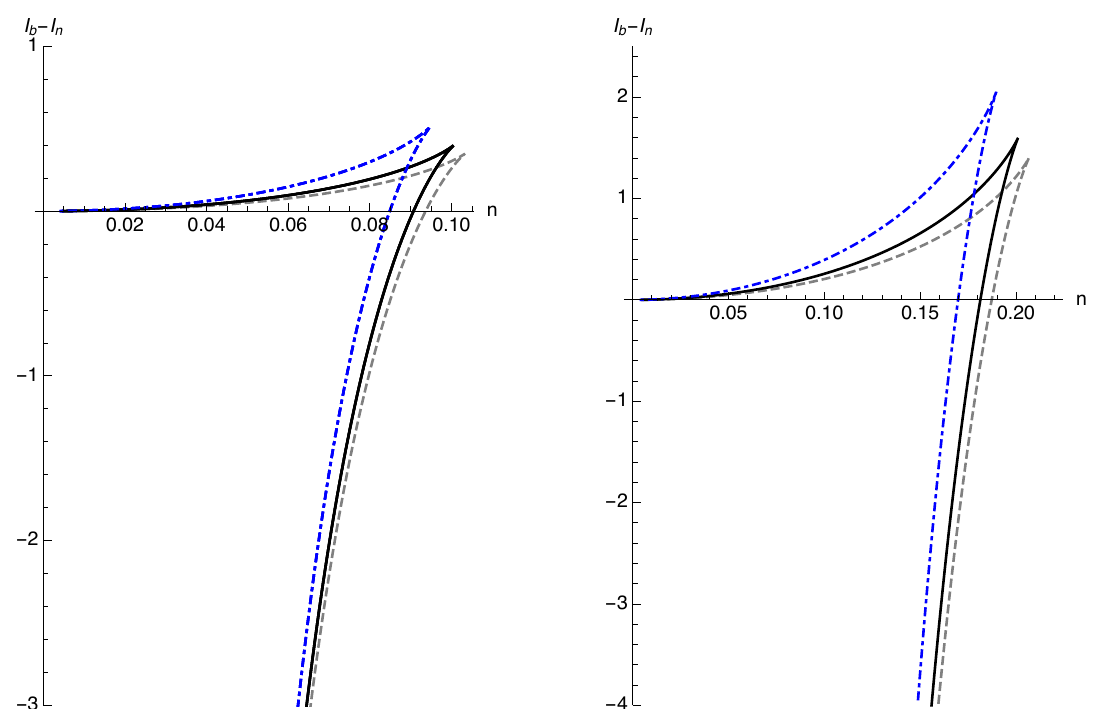
Figure 3 . Plot of the action difference I b − I n for the AdS-Taub-NUT ModMax spacetime. The left panel corresponds to l = 1 , whilst the right panel to l = 2 . From right to left, we have the values γ = 0 , 0 . 1 , 0 . 3 (dashed, solid and dot-dashed lines respectively). As γ increases, the curves move to the right so that both the critical temperature and the cusp temperature increase for a given value of l